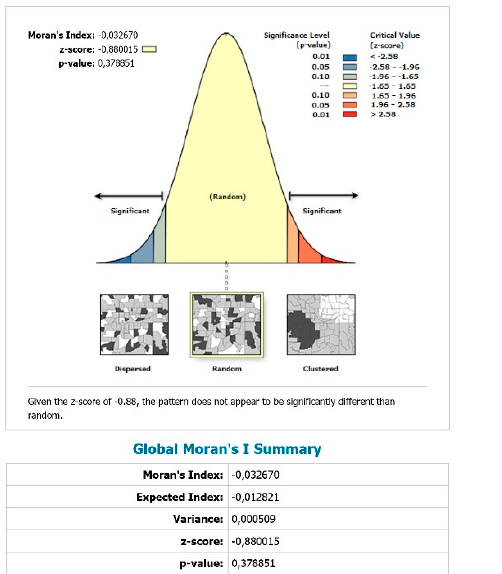
Figure 5. Final statistics and Moran ′ s diagram for standardized death rate of breast cancer per 1000 inhabitants of European Standard Population, 2007–2012. Source: Statistical Office of the Slovak Republic, 2019.